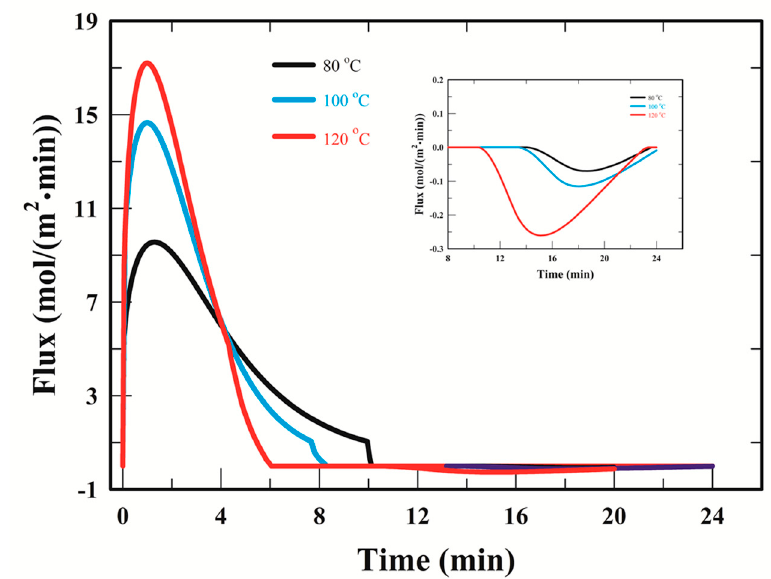
Figure 11. Simulated profiles of the mass flux on the WG surface during drying in the FBD at different set temperature. 80 °C (black line), 100 °C (blue line), and 120 °C (red line) in heating stage and cooling stage.